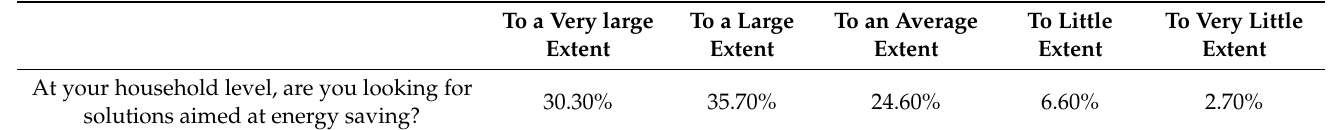
Table 7. Energy consumption behavior.